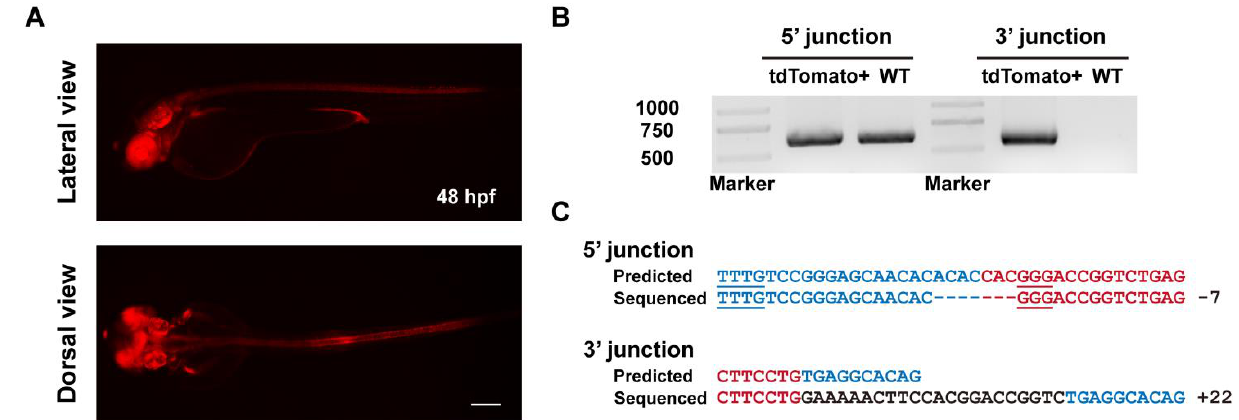
Figure 4. Evaluation of germline transmission of ErCas12a-mediated knockin with the NHEJ donor at the tbx2b locus. ( A ) Fluorescence reporter expression of F 1 embryos obtained from outcross of a tbx2b NHEJ knockin F 0 adult. Red fluorescence can be observed in the nervous system, eyes, pectoral fins, and endocardium of the F 1 embryos. Scale bar: 200 μ m. ( B ) Junction PCR results of the tbx2b knockin F 1 embryos bearing red fluorescence. Primers tbx2b F1 and tbx2b R1 were used to amplify the 5’ junction, and primers bF2 and tbx2b R1 were used to amplify the 3’ junction. Note that due to the structure of the knockin allele, the 5 ’ junction amplicon of the of knockin allele is indistinguishable from that of the WT allele by electrophoresis. ( C ) Sequencing alignment of the junction PCR products after TA cloning. As the 5 ’ junction PCR product was a mixture of amplicons from the WT and knockin alleles, only sequencing results with indel mutations in the intronic junction site were considered to be amplified from the knockin allele. Blue characters indicate the tbx2b WT allele, red characters represent the donor sequences, and black characters represent random insertions resulting from NHEJ repair. Underlined characters indicate the PAMs of the tbx2b ErCas12a site and lamgolden Cas9 site for donor linearization.